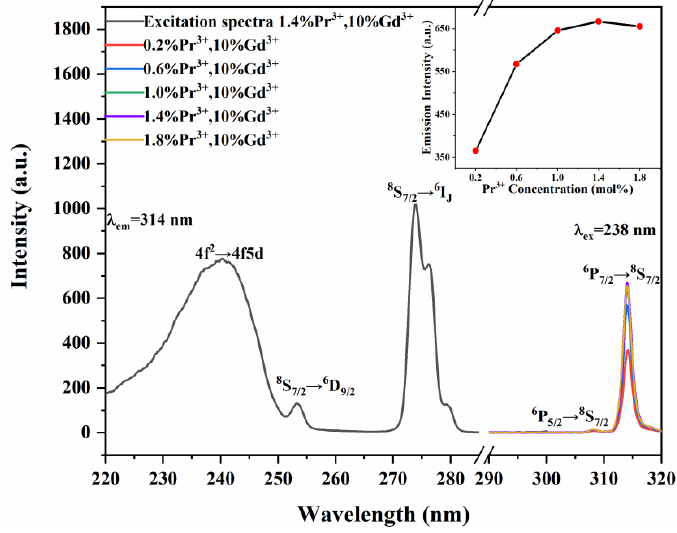
Figure 6. Excitation (λ em = 314 nm) and emission spectra (λ ex = 238 nm) of Y 7 O 6 F 9 :xPr 3+ , 10%Gd 3+ (x = 0.2%, 0.6%, 1.0%, 1.4%, 1.8%) phosphors.